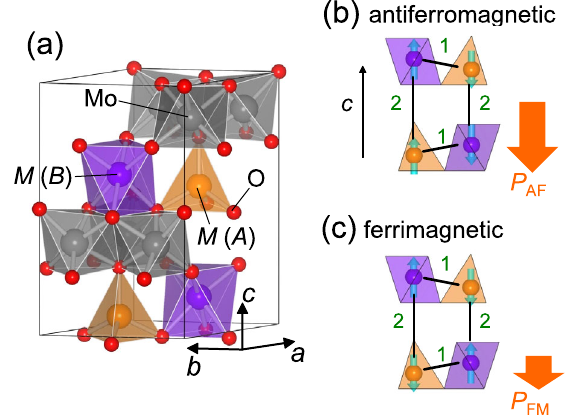
FIG. 1. (a) A unit cell of M 2 Mo 3 O 8 ( M ∶ Fe). (b, c) Schematic illustrations of antiferromagnetic and ferrimagnetic orders, re- spectively. Spin-induced P ( P and P ) are also indicated. AF FM Although the sign of P with respect to the c axis has not been determined, it is provisionally defined in this work. The numbers 1 and 2 are the indices for bonds of magnetic